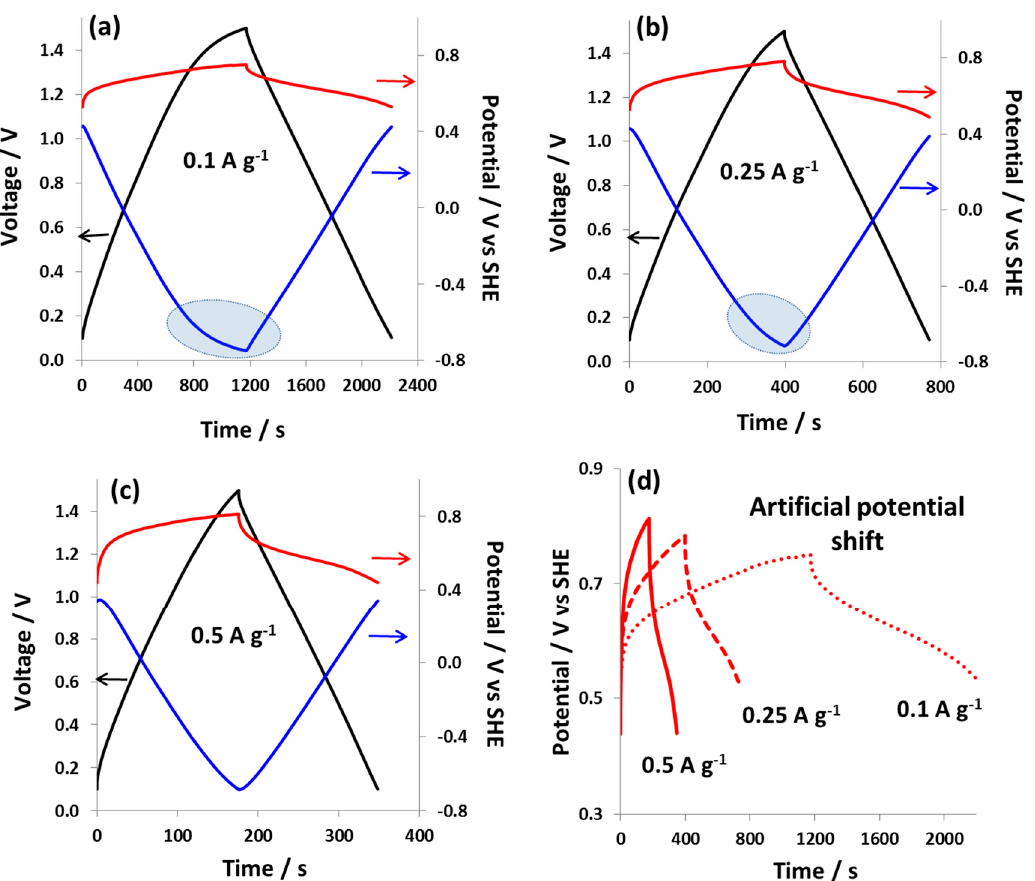
Figure 2. Galvanostatic charge / discharge curves of hybrid cell 1 in a two-electrode setup equipped with s reference electrode with 1 mol L − 1 NaI electrolyte and specific currents of ( a ) 0.1 A g − 1 , ( b ) 0.25 A g − 1 , ( c ) 0.5 A g − 1 and ( d ) the charge / discharge curves of the positive battery-like electrode at di ff erent specific currents from 0.1 A g − 1 to 0.5 A g − 1 . Potentials of the positive and negative electrode are plotted in red and blue, respectively.